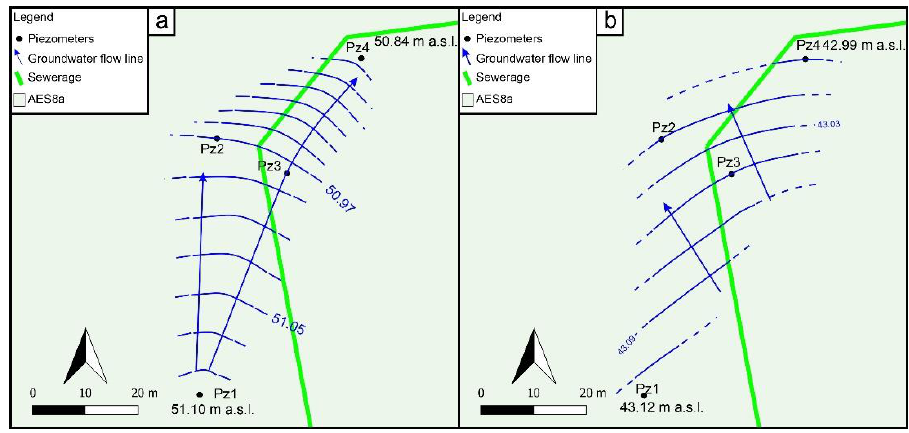
Figure 7. (a) Groundwater flow net in May 2022; (b) groundwater flow net in October 2022.